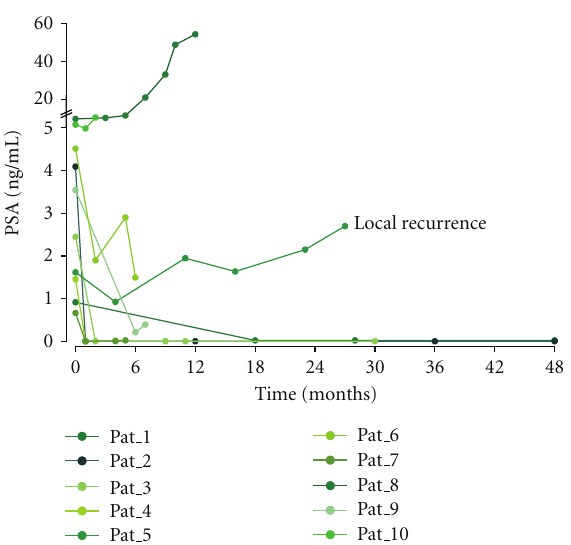
Figure 2: PSA development after secondary resection of LNM without adjuvant